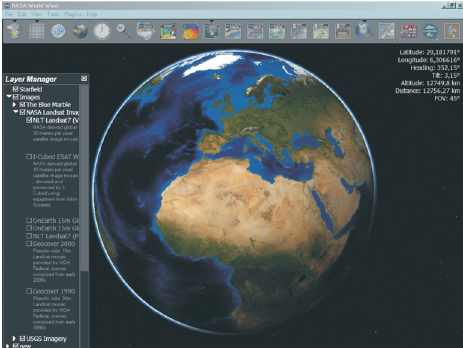
Fig. 11. Virtual Globe World Wind (J.P. Snyder